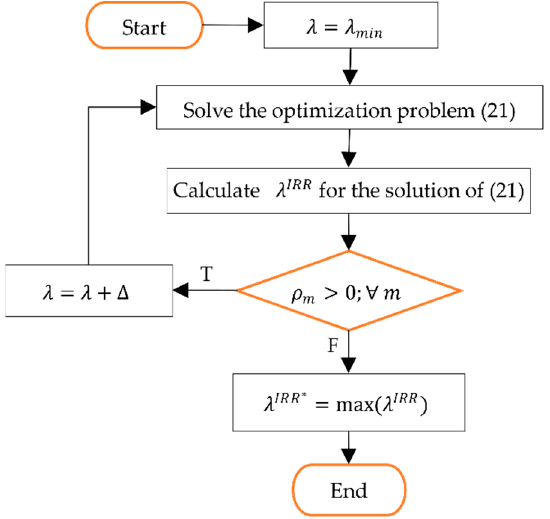
Figure 2. Flow chart to maximize the internal rate of return (IRR).